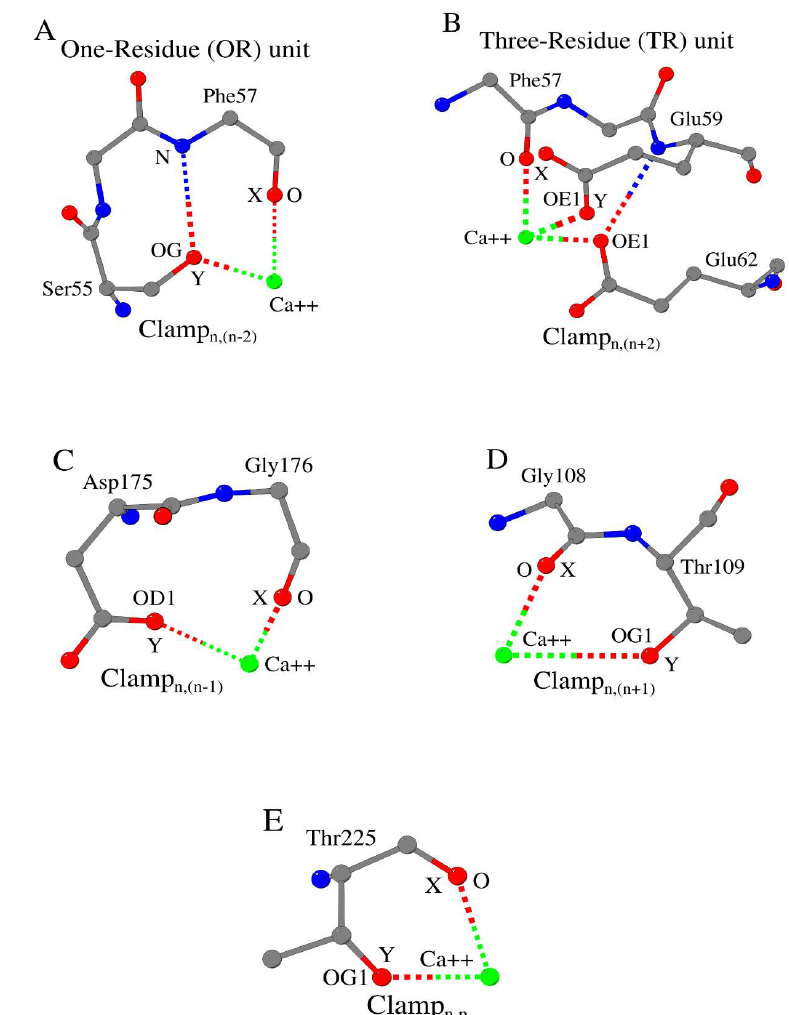
Figure 2. Five different types of local metal ion recognition substructures, observed in proteins: ( A ) Clamp n,(n-2) , ( B ) Clamp n,(n+2) , ( C ) Clamp n,(n-1) , ( D ) Clamp n,(n+1) and ( E ) Clamp n,n . Main-chain and side-chain oxygen atoms, which directly coordinate the metal cation, are shown as “X” and “Y”.